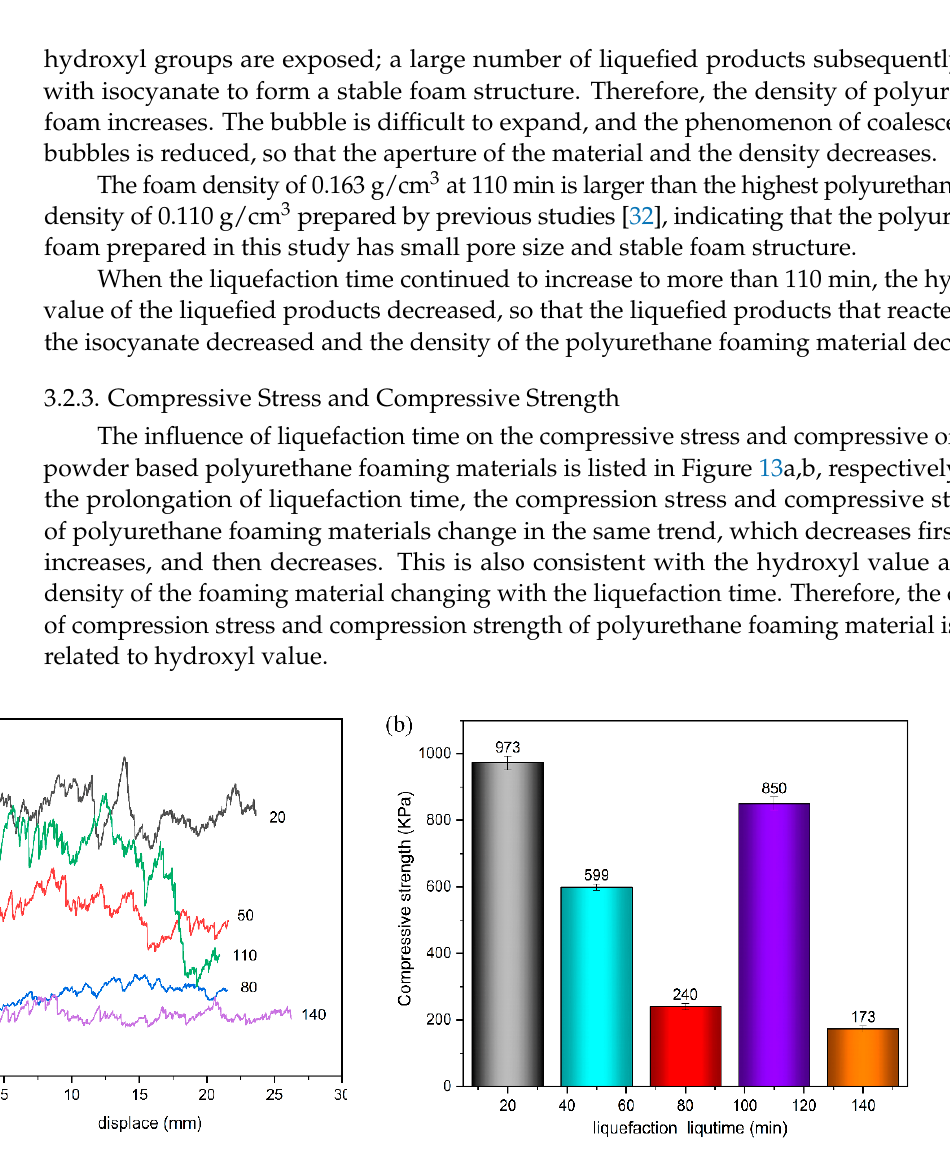
Figure 13. ( a ) The influence of liquefaction time on the compressive stress of polyurethane foaming materials. ( b ) The influence of liquefaction time on the compressive strength of polyurethane foaming materials.